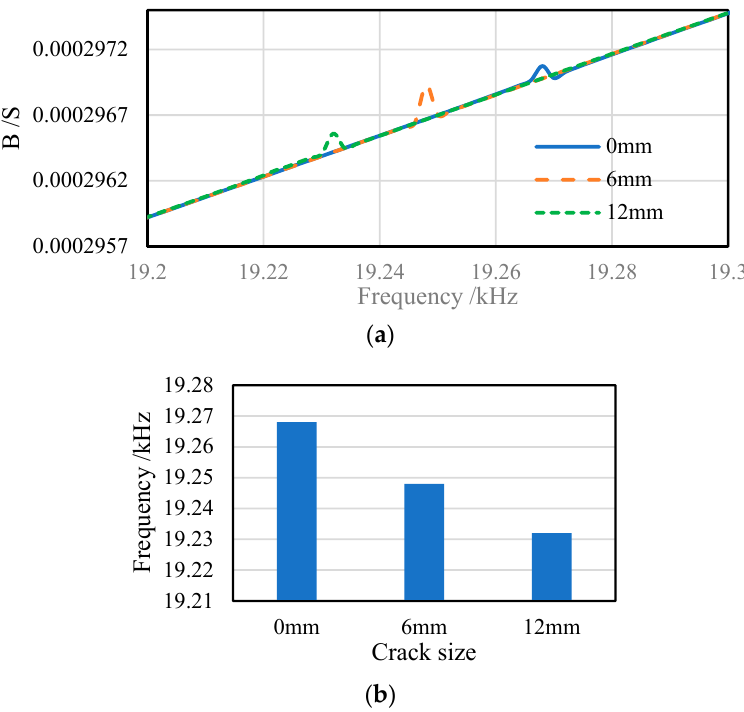
Figure 4. Numerical simulation results: ( a ) piezoelectric admittance spectrum and ( b ) peak frequency tendencies in 19.2 kHz19.3 kHz with different crack sizes.